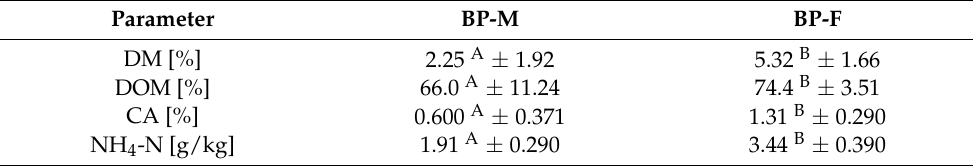
Table 2. The basic composition of pig slurry from the maternal and fattening